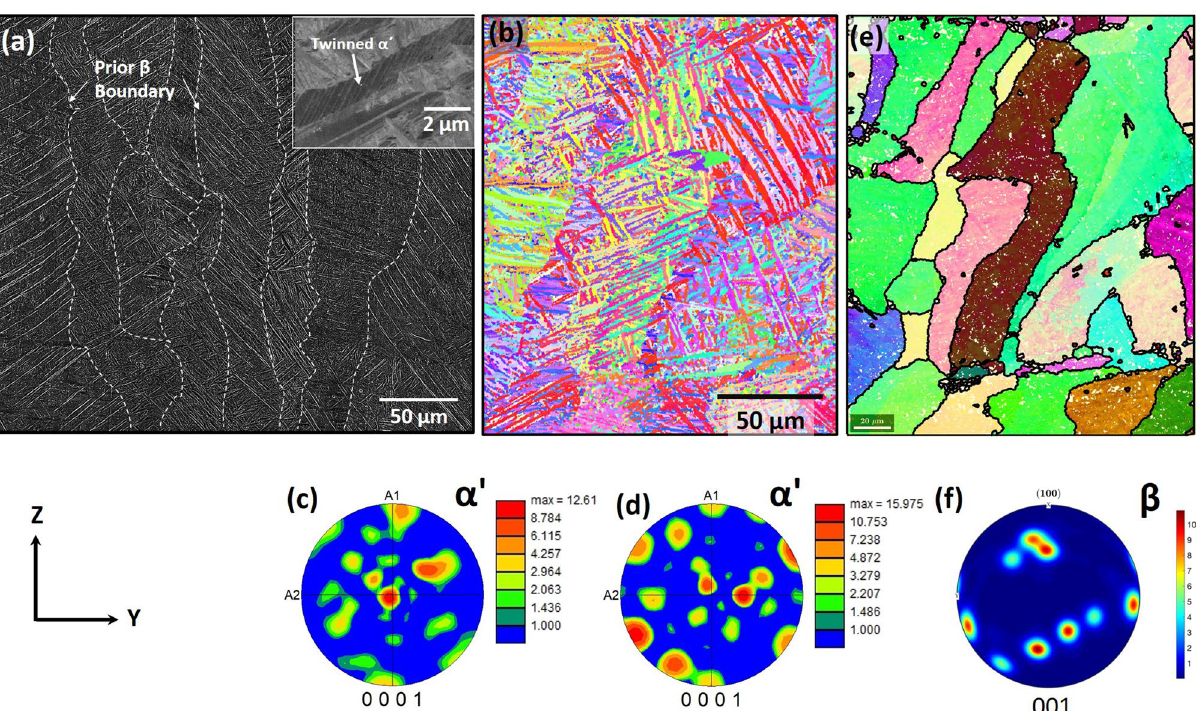
Figure 3. ( a ) SEM and ( b ) EBSD IPF map of LPBF-AM Ti6Al4V cube from YZ-plane and ( c ) corresponding and ( d ) additional 0001 pole figure texture plots from YZ-plane. ( e ) Numerically reconstructed prior β inverse pole figure map using Mtex toolbox 5.5 25 and ( f ) corresponding 001 pole